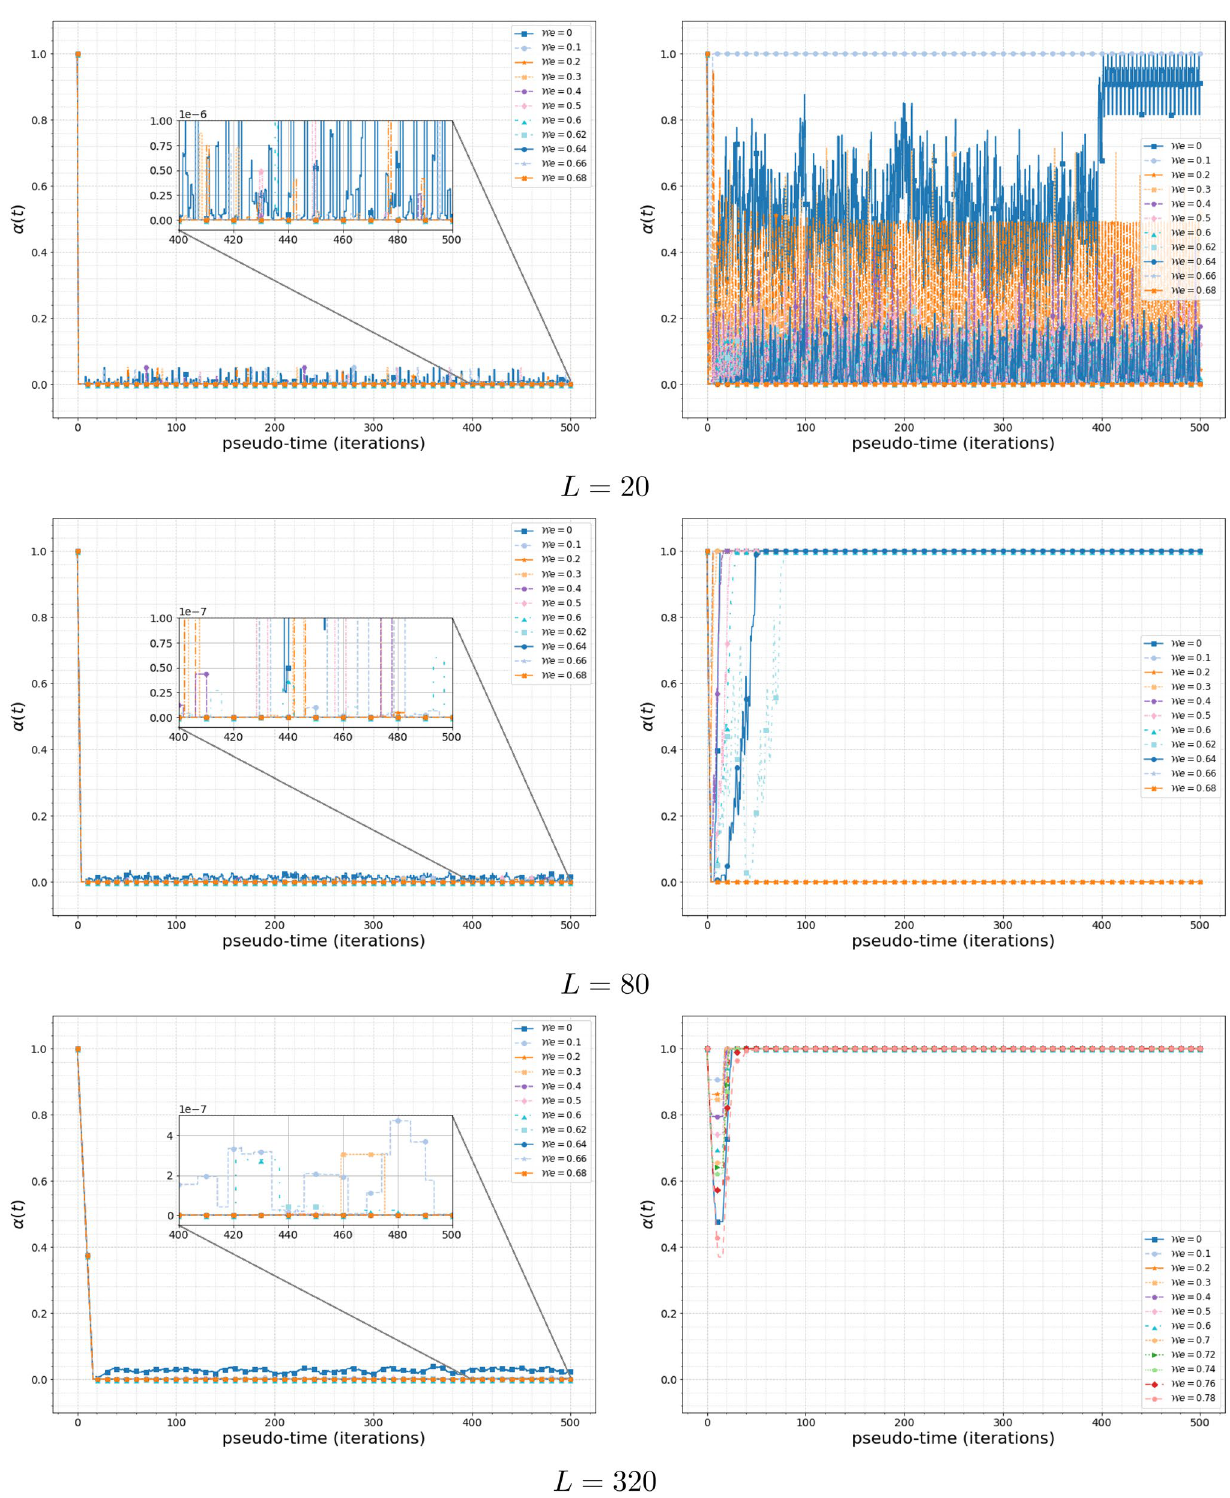
𝝉 ) (left) and 𝛼 ( ) (right) for different lengths of the averaging history p t t ‖ ‖ ‖ ‖